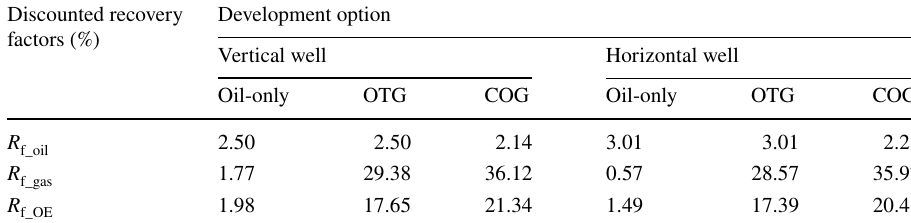
Discounted recovery factors